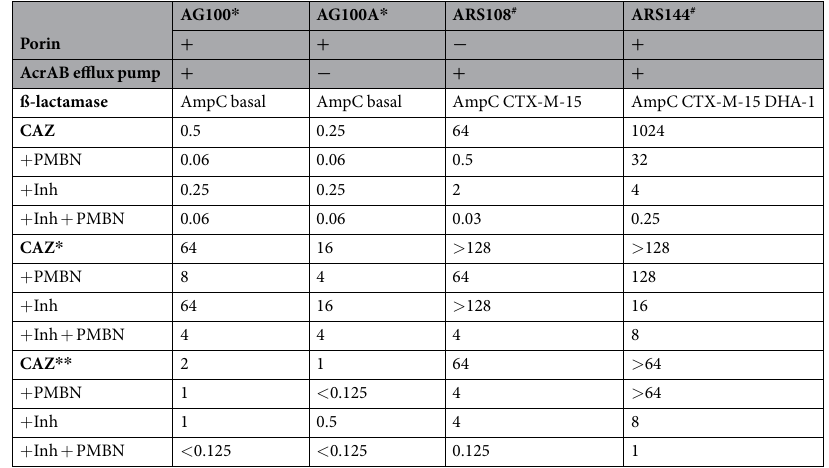
Table 1. E. coli strains susceptibilities (in mg/L) to ceftazidime and modified-ceftazidimes. * ,# Isogenic strains [AG100 (parental) and AG100A, AcrAB- derivative] and clinical isolates 17, 23, 42 . Porins and efflux components identified by Western Blot-immunodetection (OmpC or OmpF, AcrAB): -, no signal ( e.g . no OmpC, no AcrAB). CAZ, ceftazidime, CAZ * coumarin-ceftazidime, CAZ ** 6-MeOQ-ceftazidime. PMBN final concentration 51.2 mg/L for AG and 102.4 mg/L for ARS strains. Inh: tazobactam + clavulanic acid, 4 mg/L each. Values are medians of at least three independent experiments and are presented in